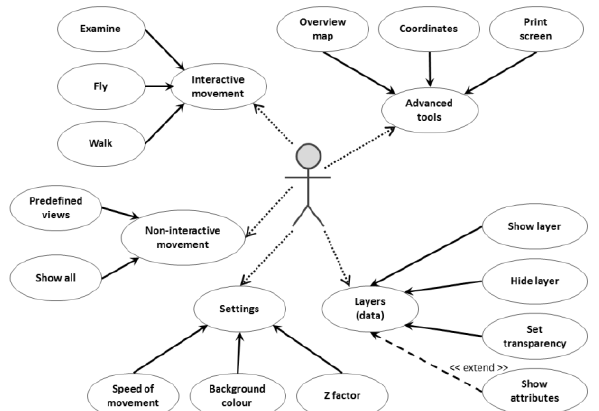
Table 2. Overview of WebGL-based programming libraries for the 3D visualization of spatial data